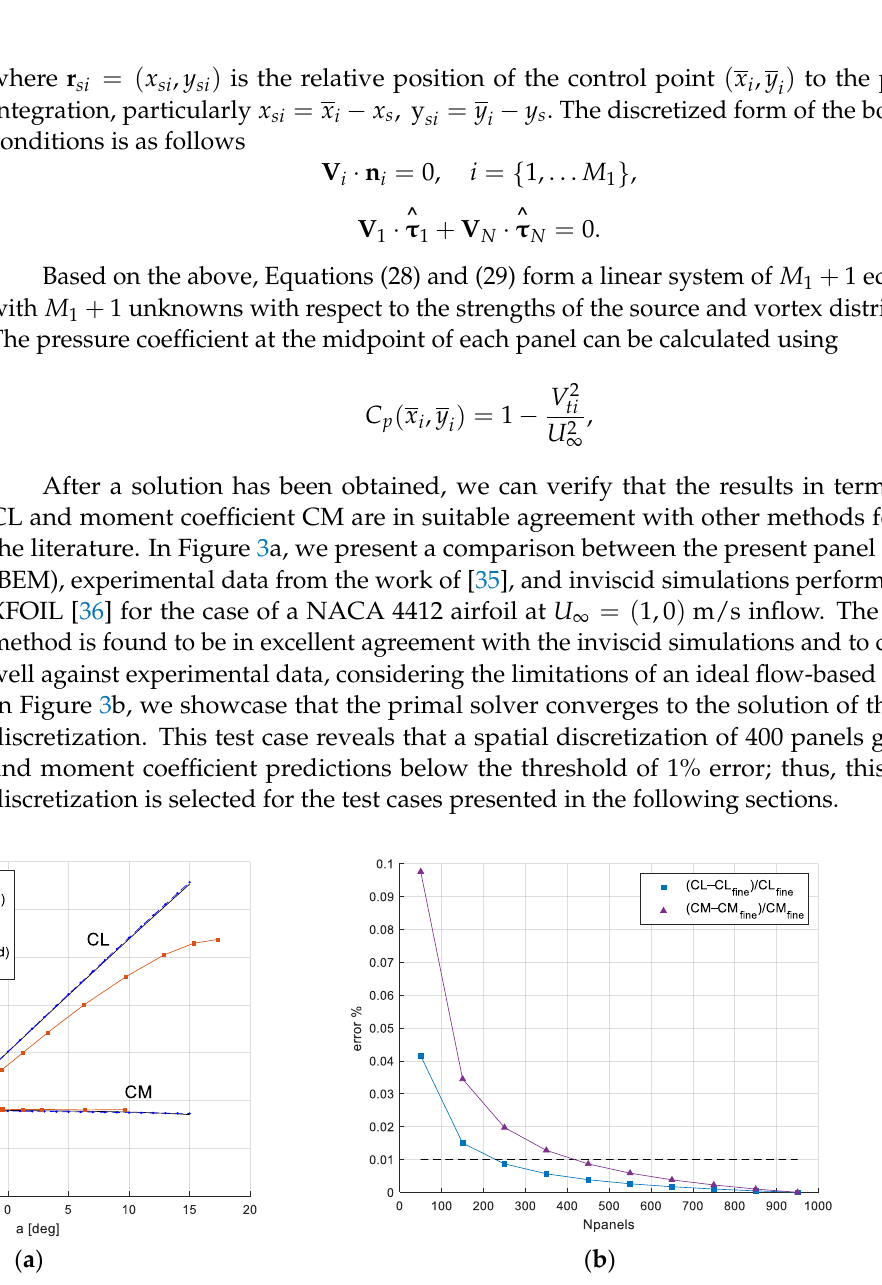
Figure 3. Numerical results for the NACA 4412 hydrofoil. ( a ) Comparison between the present panel method (BEM), experimental data found in the work of [35], and inviscid simulations with XFOIL [36]. ( b ) Convergence study for the primal solver for a = 4deg.